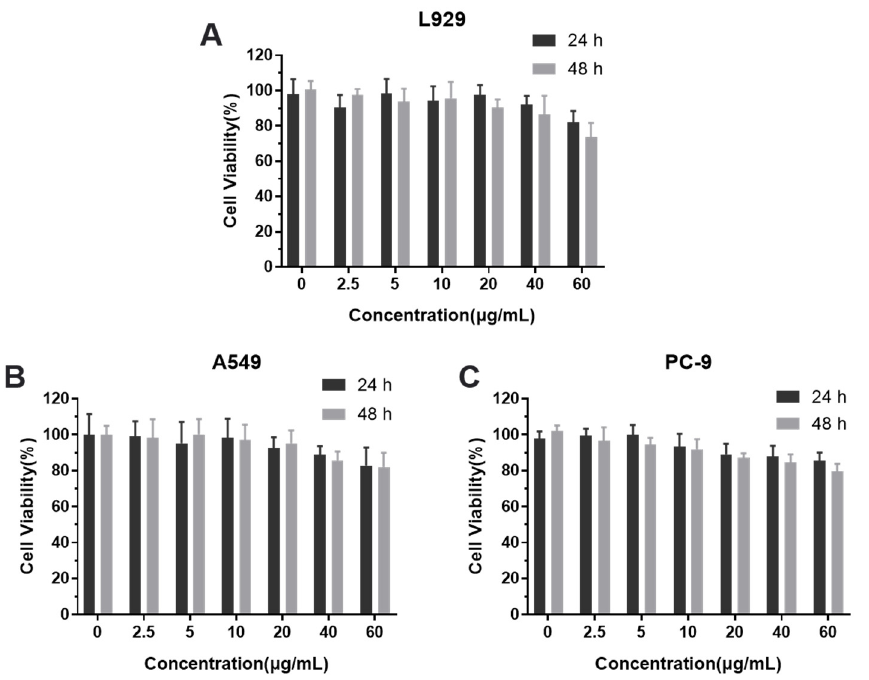
Figure 5. Cytotoxicity of CMC- β -CD Ngs in ( A ) L929 cells, ( B ) A549 cells and ( C ) PC-9 cells at different concentrations after 24 h and 48 h.